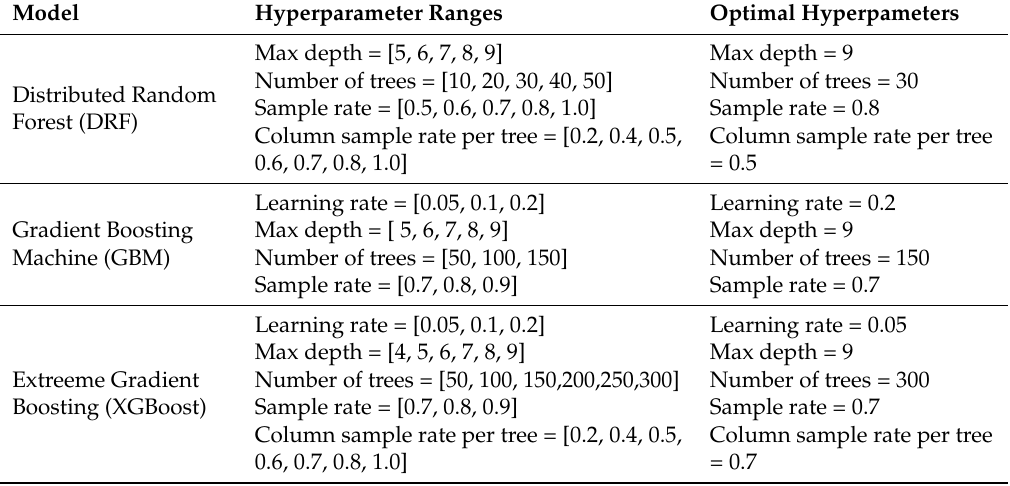
Table A3. Hyperparameter ranges and optimal